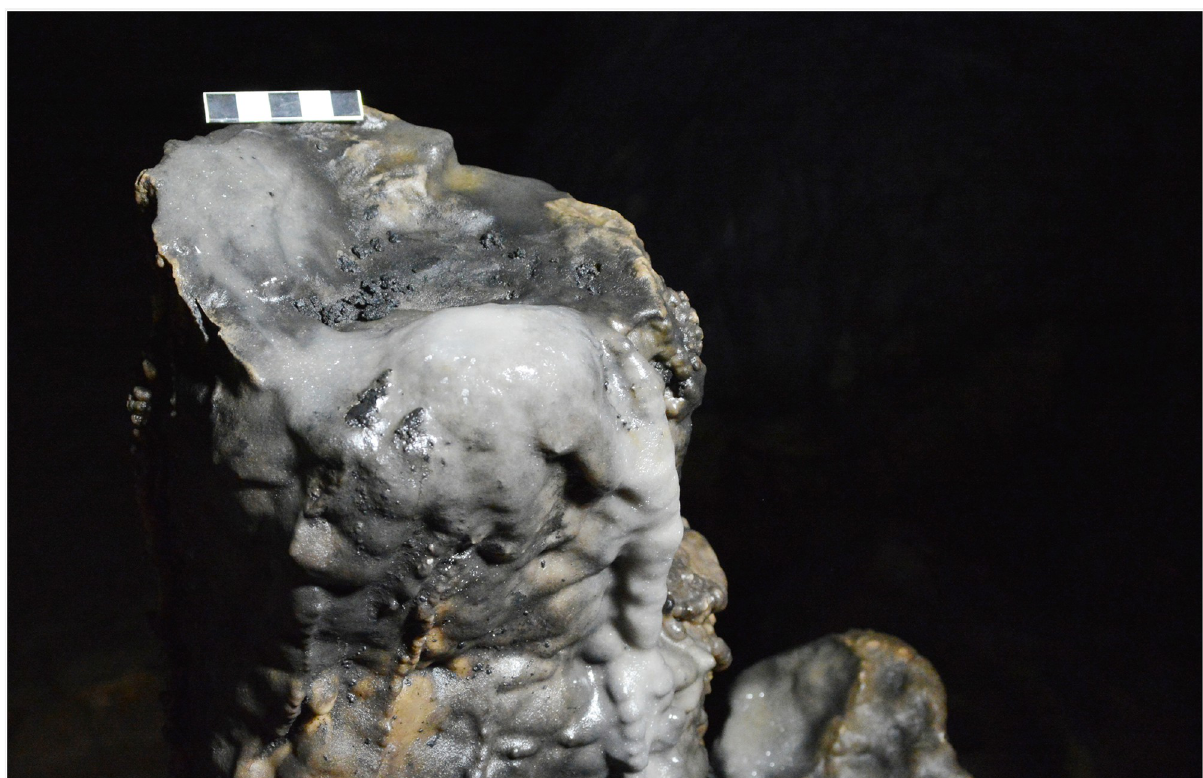
Fig 17. Capped stalagmite used as a stationary lamp during the Neolithic/Copper Age.